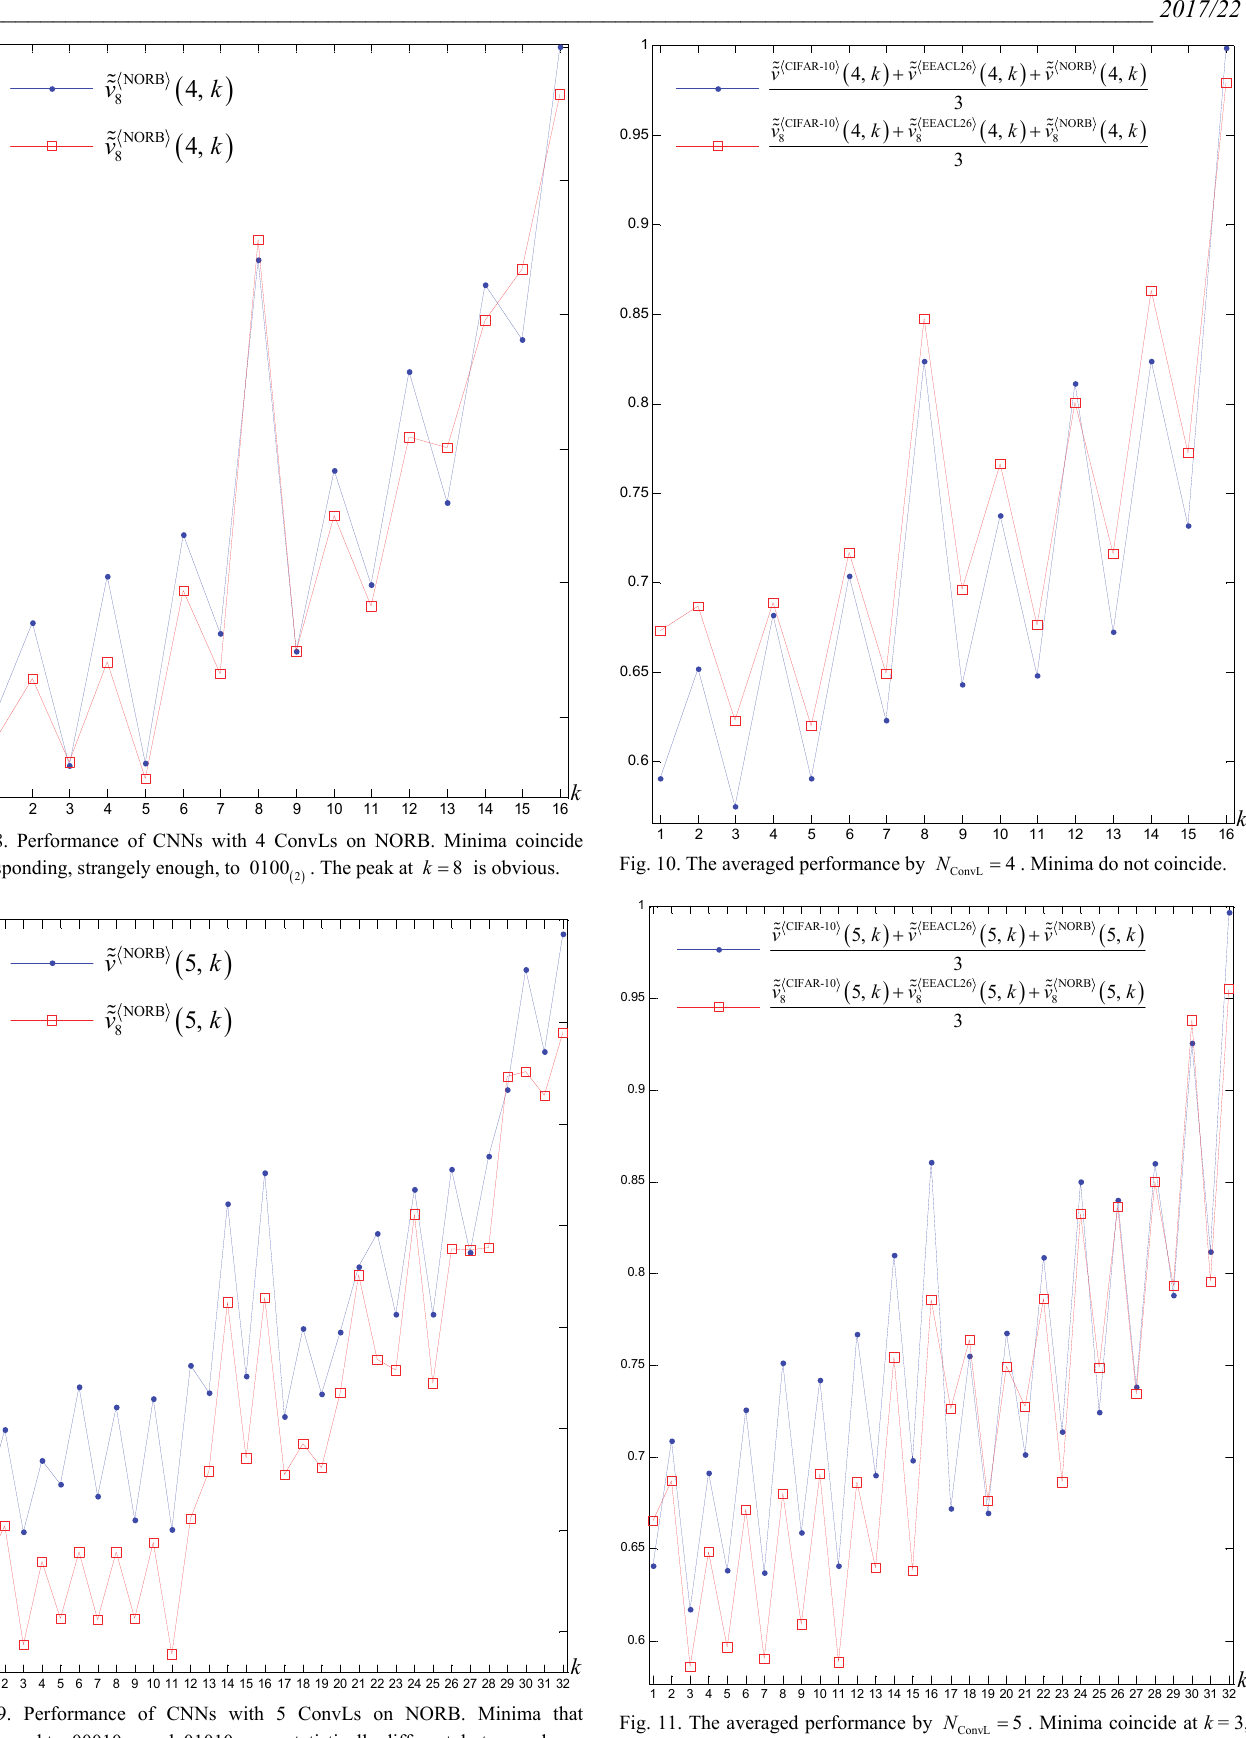
Fig. 11. The averaged performance by although final-epoch performance is close to the best at 11 k  (see Fig.